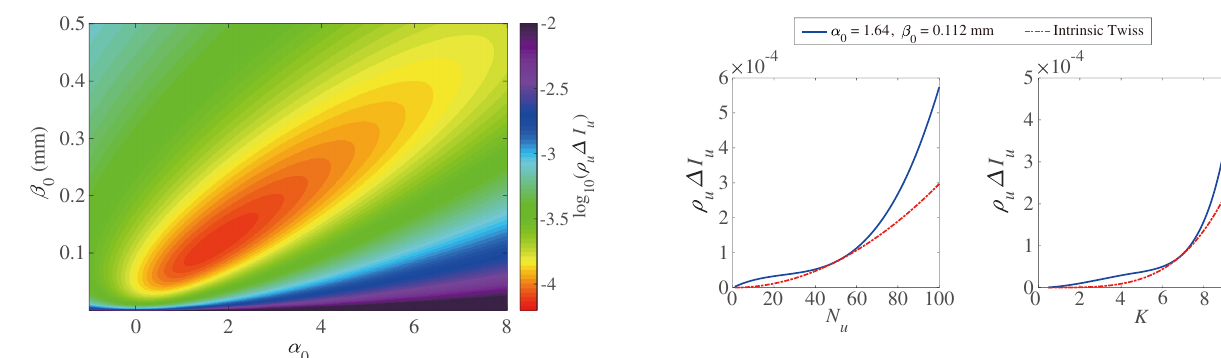
FIG. 6. The contribution coefficient Δ I u to the longitudinal emittance of an undulator or wiggler. To make it dimensionless, the peak curvature radius of the undulator ρ u ¼ γ c The wiggler parameters are λ U ¼ 5 cm, N u ¼ 50 , and K ¼ 6 . 857 . The best value appears around ð α 0 ; β 0 Þ ¼ ð 1 . 64 ; 112 μ m Þ .